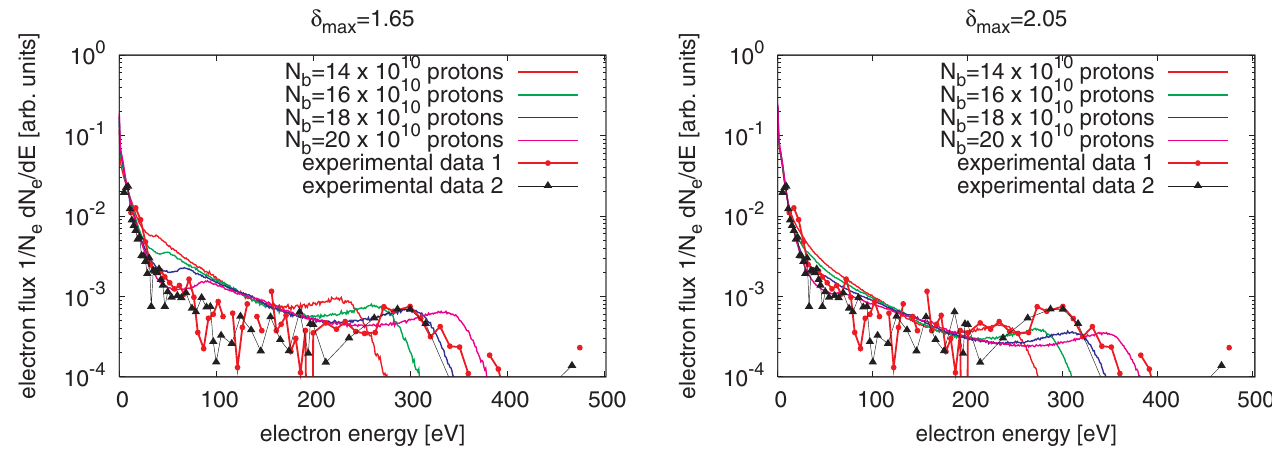
(cid:4) 1 : 65 (right) (cid:5) (cid:4) 2 : 05 (left) and different bunch intensities. The spectrum shape is not max max , but it depends on the beam parameters (bunch intensity, length, etc.). max